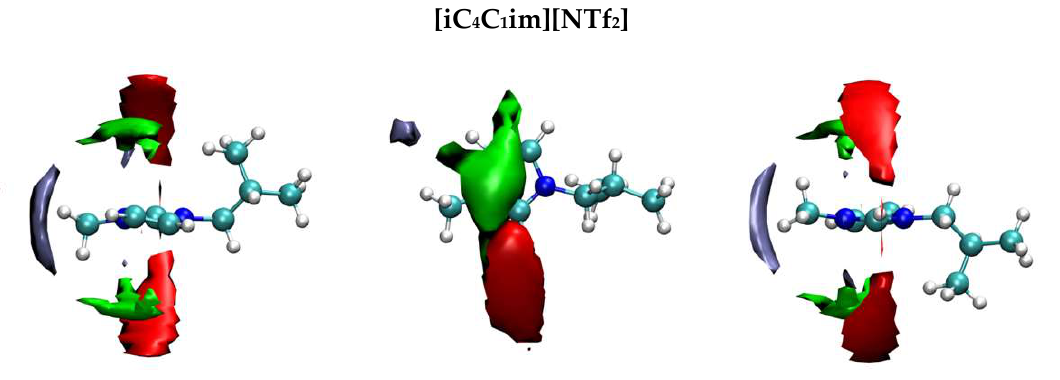
Figure 2. Selected spatial distribution functions around the imidazolium cation in aqueous mixtures X IL = 0.70 (wt IL = 98%) of [C 3 C 1 im][NTf 2 ], [C 4 C 1 im][NTf 2 ], and [iC 4 C 1 im][NTf 2 ] at 320 K. The red and green colors represent N and F atoms of the anion, respectively, and light blue depicts water O atom. The isosurface value is 70% of the maximum number density.